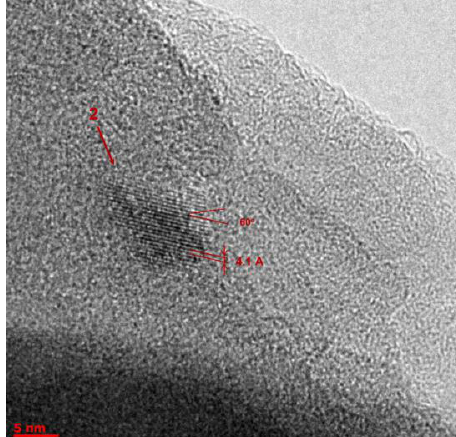
Figure 13. TEM image of Object 2 as a cluster of complex shape. The lattice parameter is 4.2 Å . The angle between three neighboring atoms in the plane is 60 degrees (rhombus).